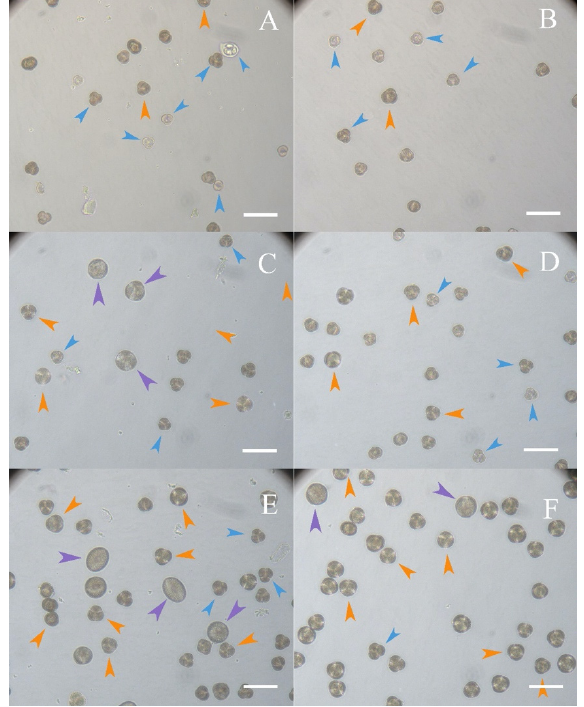
Figure 2. Preparations of mustard ‘Sudarushka’ on day 1 of cultivation with different methods of isolation and sizes of buds. ( A , C , E )—microspore isolation number 2; ( B , D , F )—microspore isolation number 3; ( A , B )—bud size 2.5–2.9 mm; ( C , D )—bud size 2.9–3.3 mm; ( E , F )—bud size 3.3–3.7 mm; blue arrows—microspore fraction No. 1; orange arrows—microspore fraction No. 2; lilac arrows— microspore fraction No. 3. Scale bars = 50 µ m.